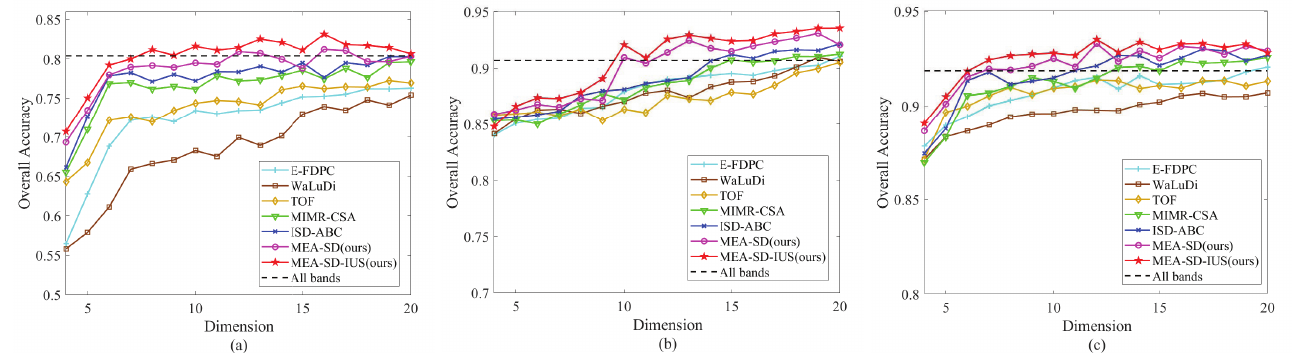
Figure 7. OA curves of different methods on three datasets. ( a ) Indian Pines. ( b ) Pavia University. ( c )